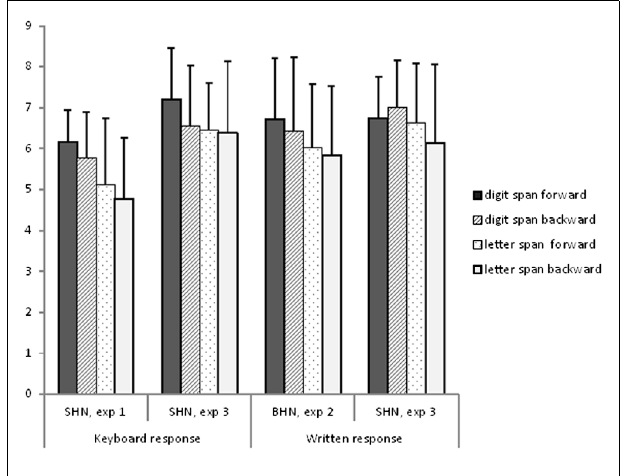
FIGURE 3 | Mean forward and backward digit and letter span for all hearing non-signers from Experiment 1 to 3 divided by response mode and cultural